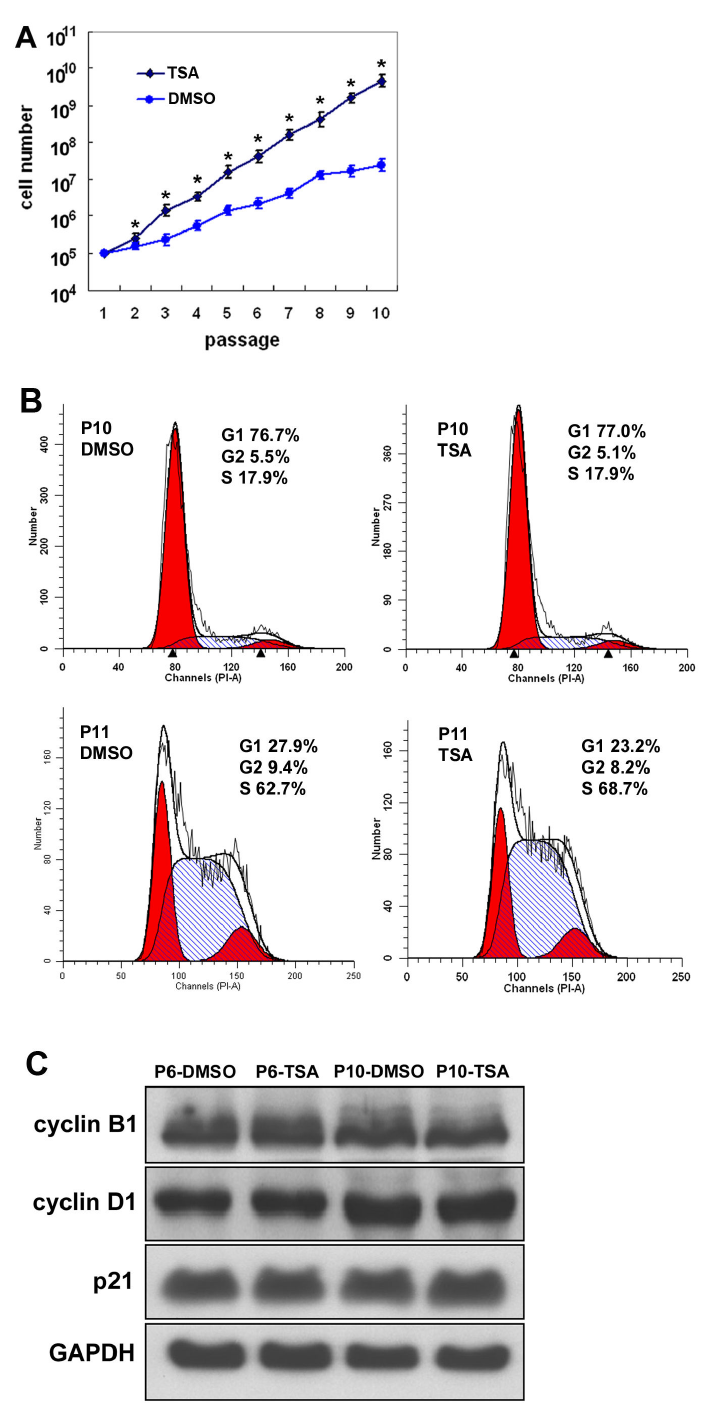
Figure 3. Influence of TSA on the growth and cell cycle of hMSCs. Passage (P)1 hMSCs were grown in the presence of TSA (at 6.25 nM) or vehicle DMSO to passage 10. (A) Cumulative cell numbers were counted (n=3, * P <0.01). (B) Cell cycle analysis of passage 10 hMSCs in full confluence showed similar percentages of hMSCs arrested in G1 phase (upper panel). When the cells were passaged to new culture plates (passage 11) and incubated in the growth medium for 24 hours ( ~ 30% confluence), a higher percentage of TSA-treated hMSCs were found in S phase (lower panel). (C) Western blot analysis of hMSCs in passage 6 and passage 10 hMSCs in full confluence for the expression of cell cycle proteins cyclin B1, cyclin D1 and p21. The experiments were repeated three times with similar results and representative results from one experiment were shown. doi: 10.1371/journal.pone.0081781.g003 PLOS ONE |